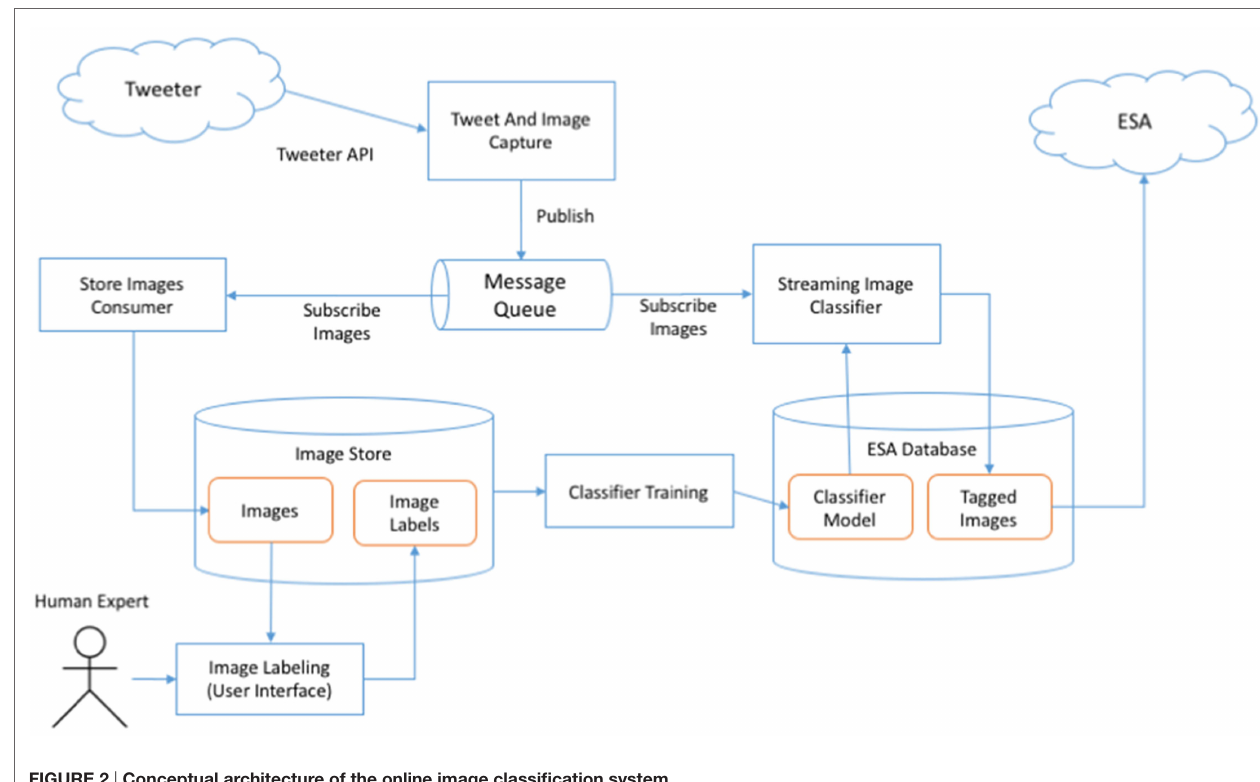
FIgURe 2 | conceptual architecture of the online image classification system